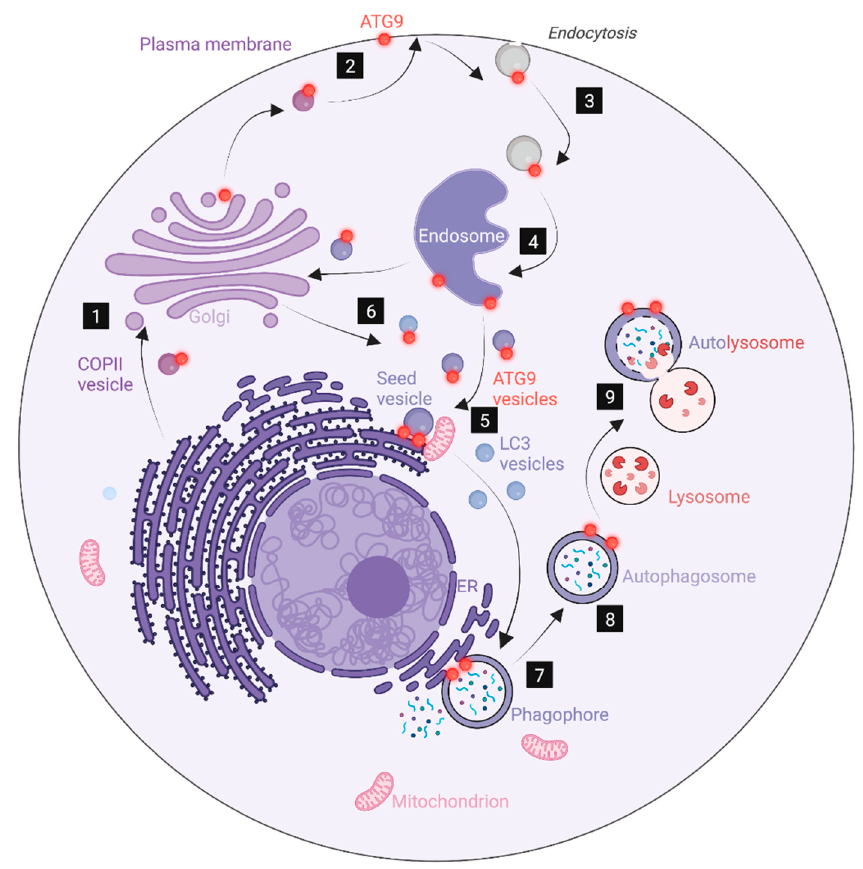
Figure 3. An ATG9-centric model for autophagosome biogenesis. ATG9 molecules (red) follow the biosynthetic pathway from the ER (1) to the plasma membrane (2) via the Golgi. ATG9 at the plasma membrane is endocytosed (3) and reaches endosomes (4), from where it can enter into vesicles that fuse to form seed vesicles for phagophores (5), possibly together with ATG9-containing vesicles coming from the biosynthetic pathway (6). Lipids generated in the ER and mitochondria are transported from the ER to the seed vesicle via the lipid channels ATG2 and VPS13 (not indicated). In conjunction with ATG9-mediated transbilayer lipid transfer, this ensures vesicle growth, possibly aided by fusion with vesicles that contain Atg8 proteins. Upon growth, the vesicle flattens to form the phagophore (7), which ultimately closes to form the autophagosome (8). The autophagosome fuses with a lysosome to form an autolysosome (9), in which the engulfed cytoplasm is degraded. In this model, the contributions to autophagy of ER-Golgi transport, endocytosis, and endosomal budding are related to their involvement in ATG9 trafficking. Prepared with BioRender (www.biorender.com) and accessed on 15 February 2023.